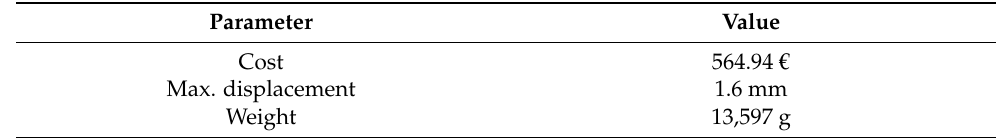
Table 2. Cost, max. displacement, and weight of the reference laminate.